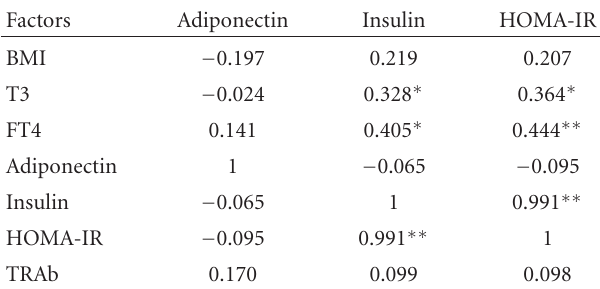
Table 3: Pearson’s correlation coe ffi cients in patients with hyper- thyroidism due to Graves’